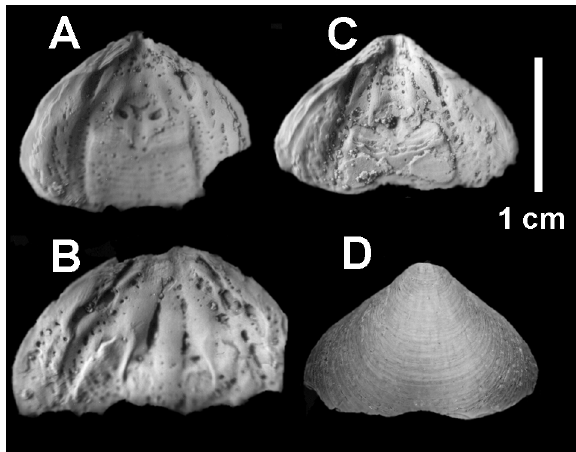
Fig. 2. Valves of Ungula inornata (Mickwitz) from the Iru section at the eastern margin of Tallinn, northern Estonia. The valves are redeposited from the (cid:220)lgase Formation to the lowermost Maardu Member of the Kallavere Formation (Cambrian, Furongian). A , ventral valve interior (GIT 275-40) with a well-preserved heart-shaped depression; B , dorsal valve interior (GIT 275-43); C , ventral valve interior (GIT 275-42); D , ventral valve exterior of specimen C (GIT 275-42).